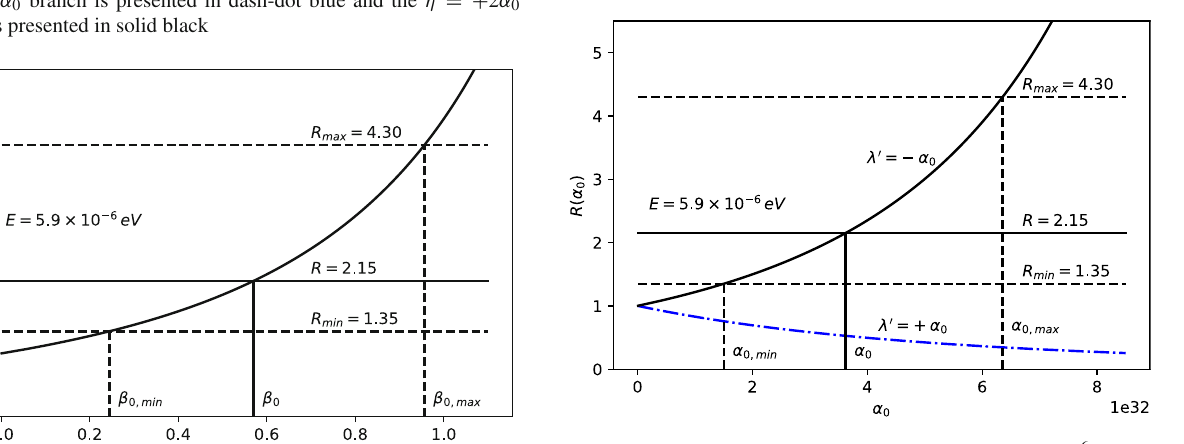
Fig. 5 R vs α 0 for fixed energy E = E 12 (cid:2) 5 . 9 × 10 − 6 eV. The λ (cid:9) = + α 0 branch is presented in dash-dot blue and the is presented in solid